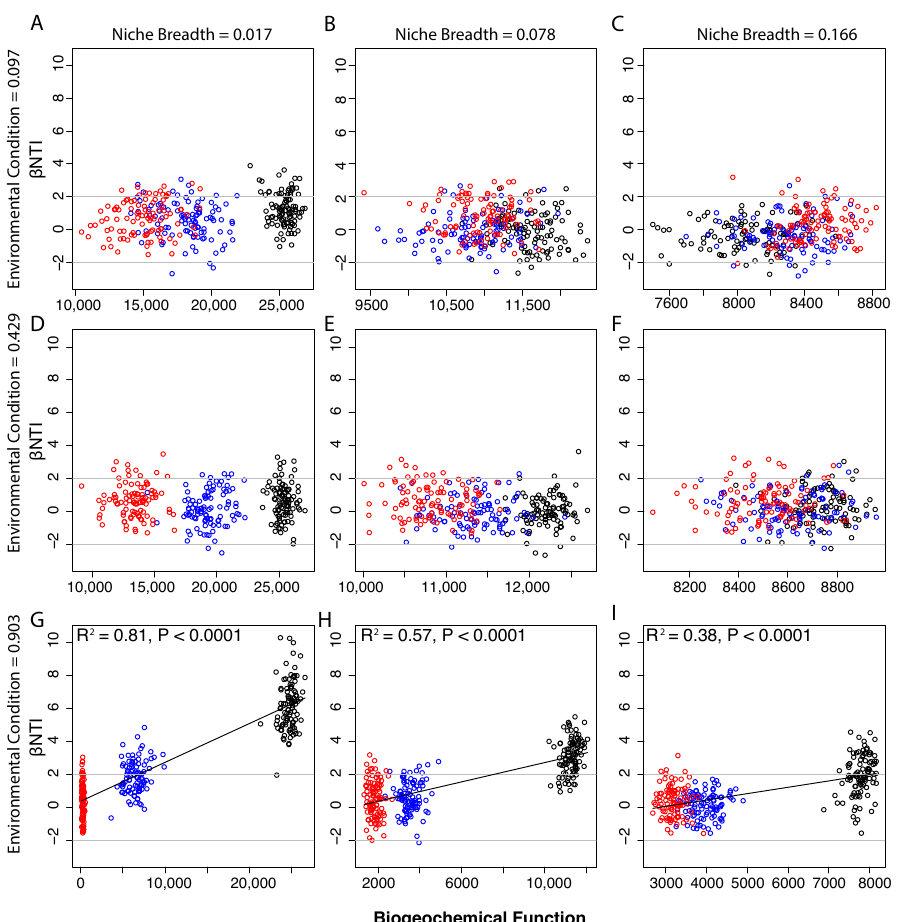
Figure 7. Relationship between β NTI and biogeochemical function across different niche breadths (columns) and different environmental conditions of the receiving communities (rows). ( A – C ), ( D – F ), and ( G – I ) depict environmental conditions similar, moderately different, and very dissimilar to that of the source community, respectively. ( A , D , G ), ( B , E , H ), and ( C , F , I ) respectively show narrow, moderate, and wide niche breadths. Values of β NTI that are further from 0 indicate increasing influences of deterministic assembly (and decreasing stochasticity). Horizontal gray lines indicate significance thresholds of − 2 and +2. Relationships were evaluated with linear regression; fitted models are shown as black lines and statistics are provided on each panel. Panels without regression models had non-significant ( p > 0.05) relationships. Note that the vertical axis is scaled the same across panels, but the horizontal axis is not. Black, blue, and red symbols indicate selection-only, moderate dispersal, and homogenizing dispersal scenarios,